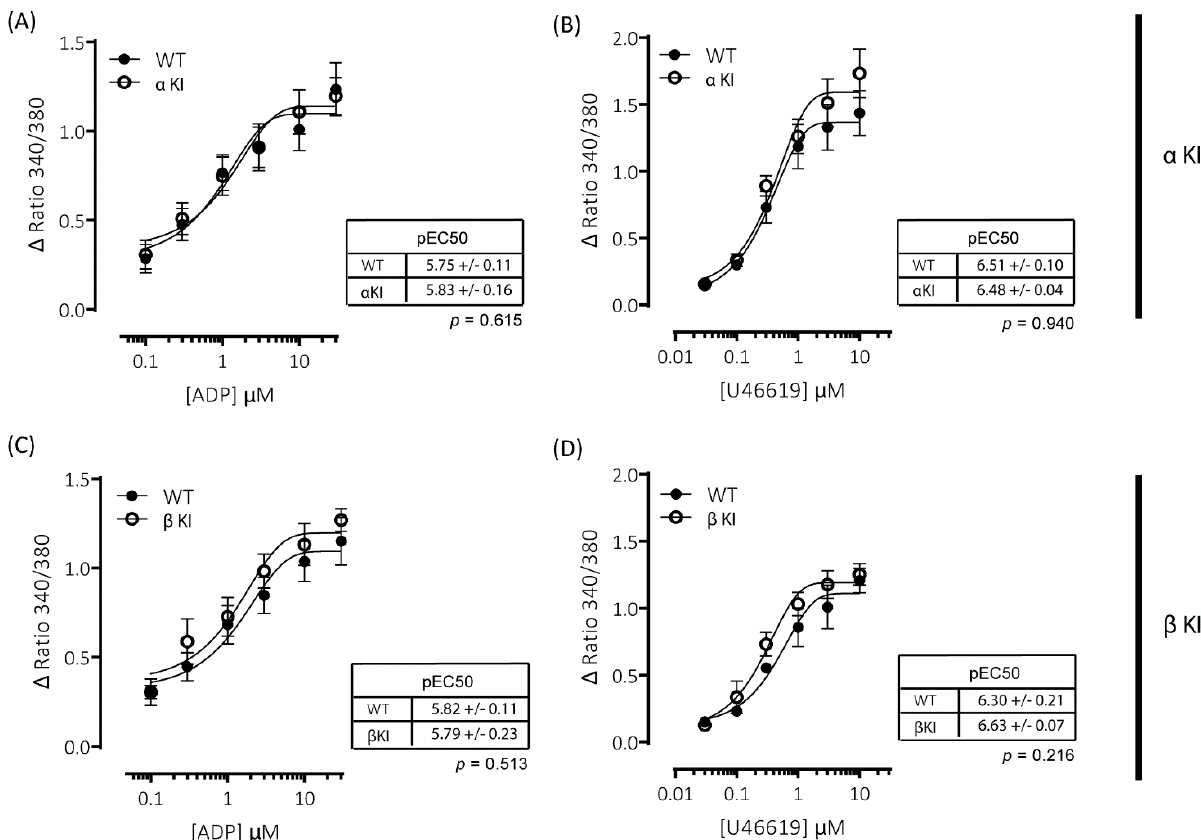
Figure 7. ADP- and U46619-elicited changes in intracellular [Ca 2+ ] are comparable between wild-type and phosphorylation-resistant GSK3 α or GSK3 β platelets. Changes in intracellular [Ca 2+] were determined by loading platelets with the calcium indicator Fura-PE3 AM and monitoring fluorescence at 340/380 nm on an Infinite ® 200 PRO multimode reader (TECAN, Reading, UK). Platelets from α KI mice had no significant alterations in calcium mobilisation in response to ( A ) ADP (pEC50: p = 0.74, n = 6) or ( B ) U46619 (pEC50: p = 0.43, n = 6). Platelets from β KI mice had no significant alterations in calcium mobilisation in response to ( C ) ADP (pEC50: p = 0.86, n = 3) or ( D ) U46619 (pEC50: p = 0.10, n = 3). Data are expressed as the change (minus baseline) in ratio 340/380 nm. Curves were fitted with a four-parameter logistic equation (GraphPad Prism 7.04). pEC50 values are indicated in the tables and Student’s t -test was used to test for statistical differences ( p -values indicated in figure).